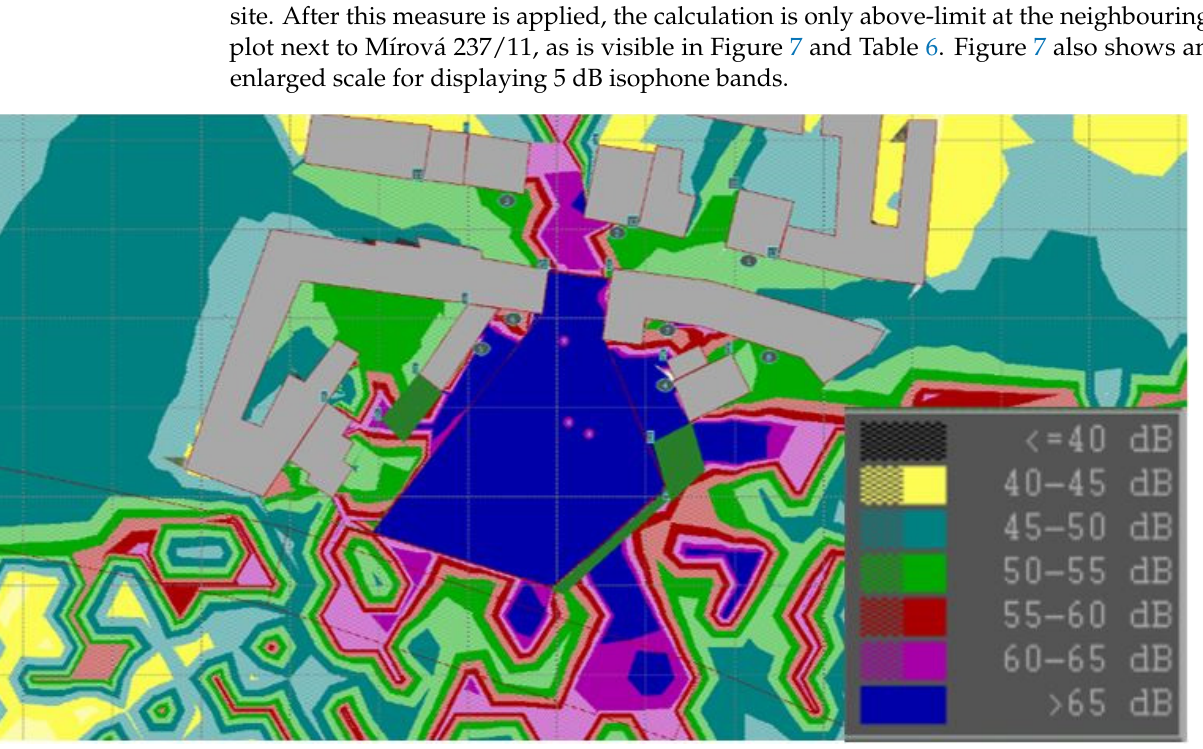
Figure 7. Colour representation of isophone bands after considering acoustically significant elements, including construction site fencing and a solid gate for the entrance to the construction site in the investigated area. Table 6. Table of calculated values of measured points for demolition work after considering acoustically significant elements, including construction site fencing and a solid gate for the en- trance to the construction site in the investigated area.